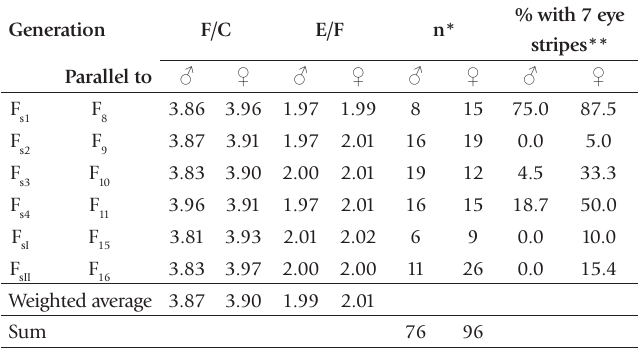
Table 2. Morphometrics of isolated Schistocerca gregaria , normal strain.